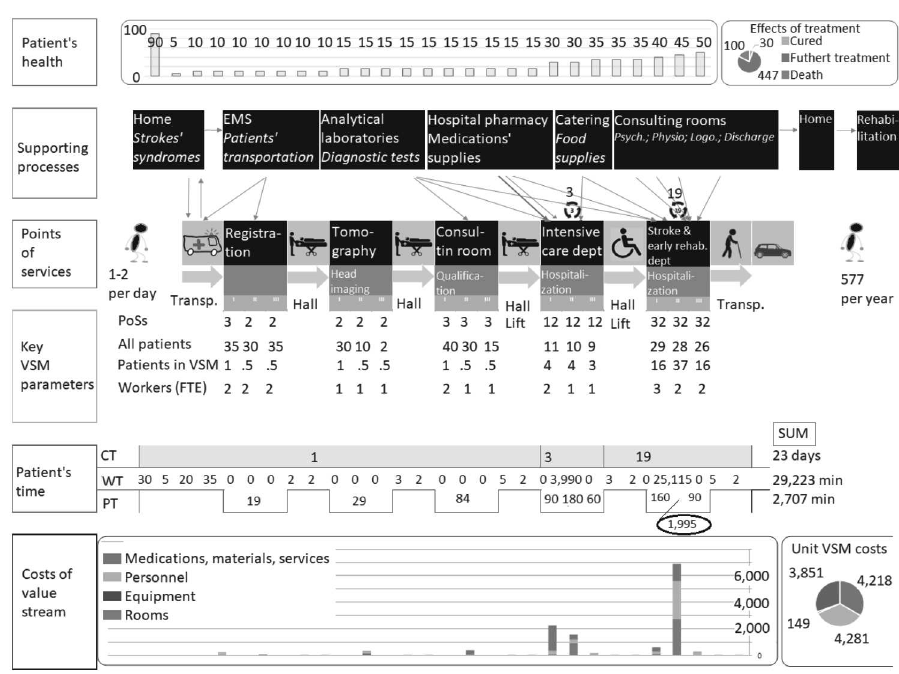
Figure 2. Current state VSM for stroke treatment in ED. Legend: CT – calen- dar time; WT – waiting or transportation time; PT – processing